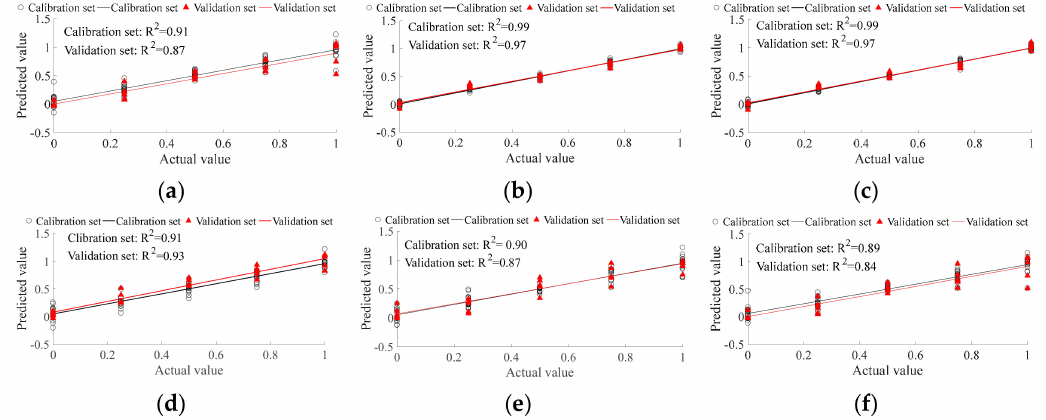
Figure 6. PLSR for ancient Pu’er tea discrimination based on E-nose. ( a – c ) are traditional feature extraction; ( d – f ) are CNN feature extraction; ( a , d ) are E-nose detection; ( b , e ) are VIS / NIR spectrometer detection; and, ( c , f ) are multi-information fusion